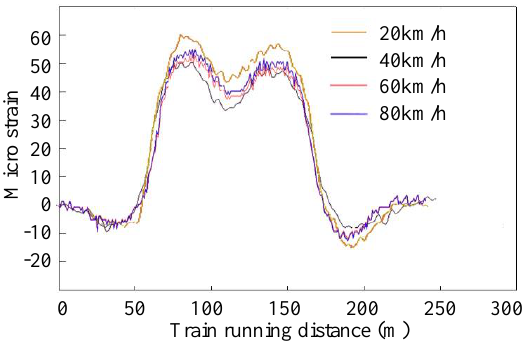
Figure 12. Strain time histories of point P1 with one train running on the bridge.